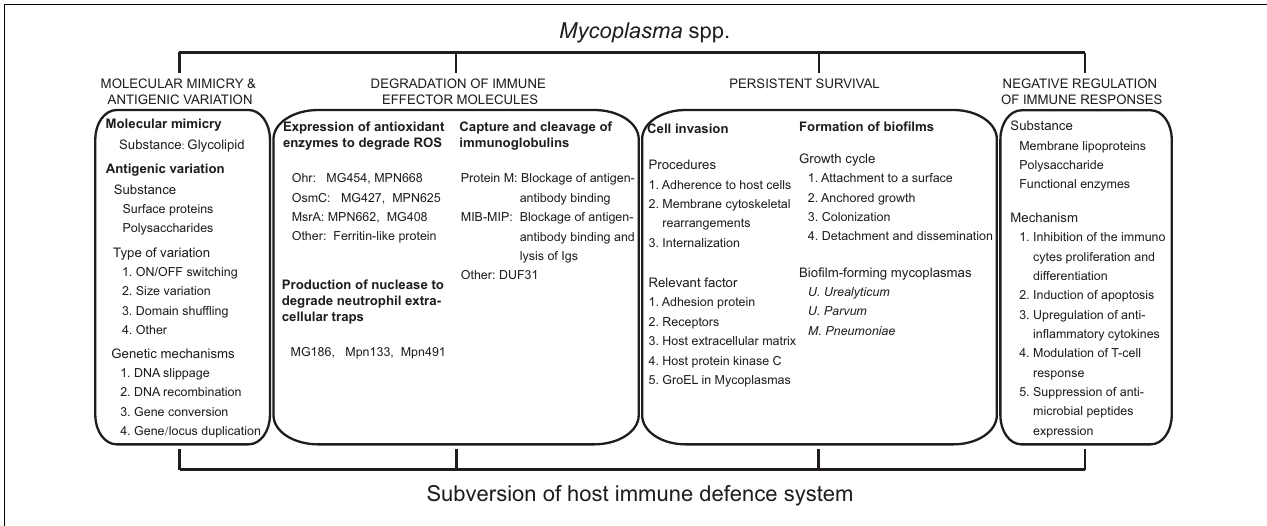
FIGURE 1 | Molecular mechanism of human pathogenic mycoplasmas to evade the host Immune attack.